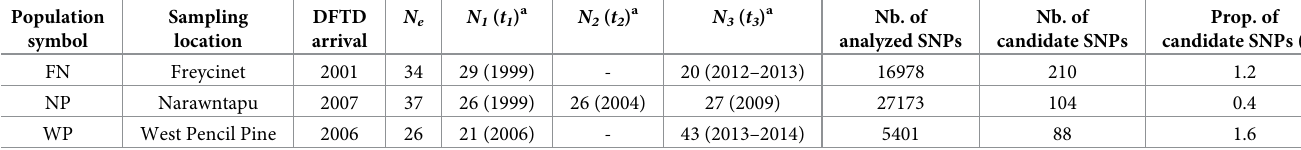
N e , effective population size a Time-series include either two (for FN and WP) or three (for NP) temporal samples. N The year of sampling, t i , is provided between brackets.